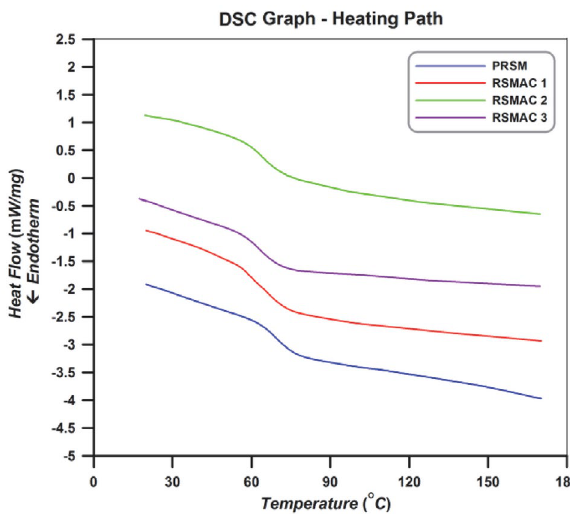
Figure 12. DSC Thermograms of the PRSM and RSMAC 1-3